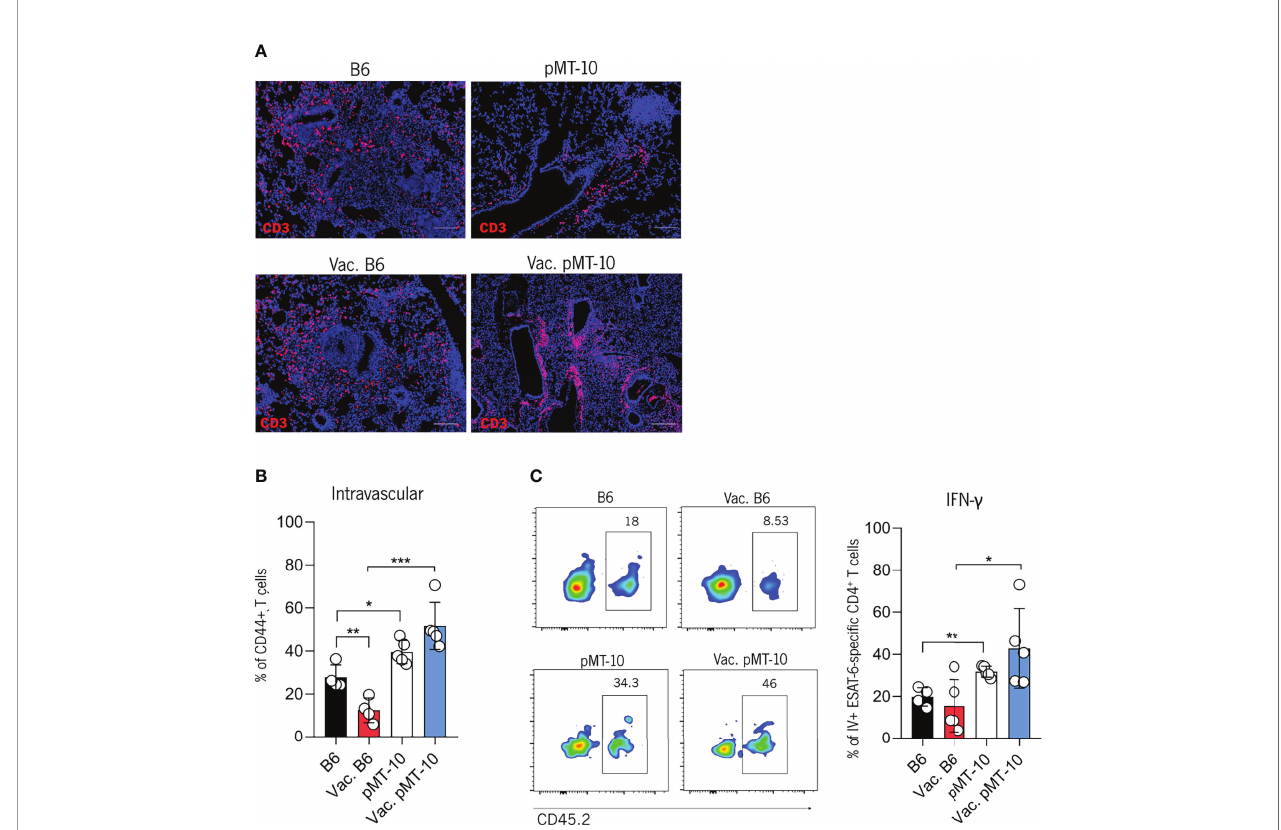
FIGURE 3 | IL-10 overexpression impairs the migration of Mtb-speci fi c CD4 + T cells to the lung parenchyma of Mtb-infected mice. B6 and pMT-10 mice were subcutaneously vaccinated with 1 × 10 6 BCG. Unvaccinated mice were used as controls. Two months after vaccination, mice were infected with Mtb H37Rv via the aerosol route and IL-10 overexpression was initiated. (A) Representative immuno fl uorescence of CD3 + cells in lungs of mice at day 30 post-Mtb infection. (B) Frequency of intravascular (CD45 + ) CD4 + T cells in the lungs of mice at day 30 post-Mtb infection. (C) Flow cytometry analysis and frequency of intravascular (CD45 + ) ESAT-6-speci fi c IFN- g – producing CD4 + T cells in the lungs of mice at day 30 post-Mtb infection. Scale bar: 100 µm. Data represent one experiment out of two independent experiments performed, each with four to fi ve mice per group. *p < 0.05, **p < 0.01, ***p < 0.001 by one-way ANOVA followed by Tukey ’ s